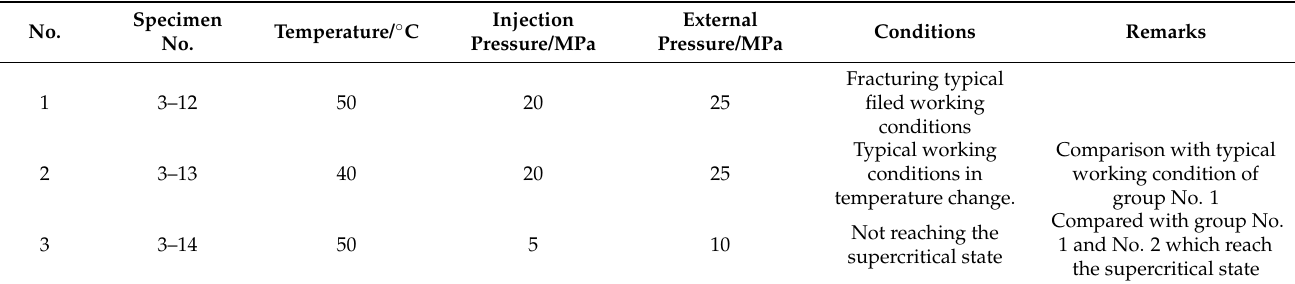
Table 3. Experimental validation scheme of multi-field coupling of supercritical CO 2 with shale.